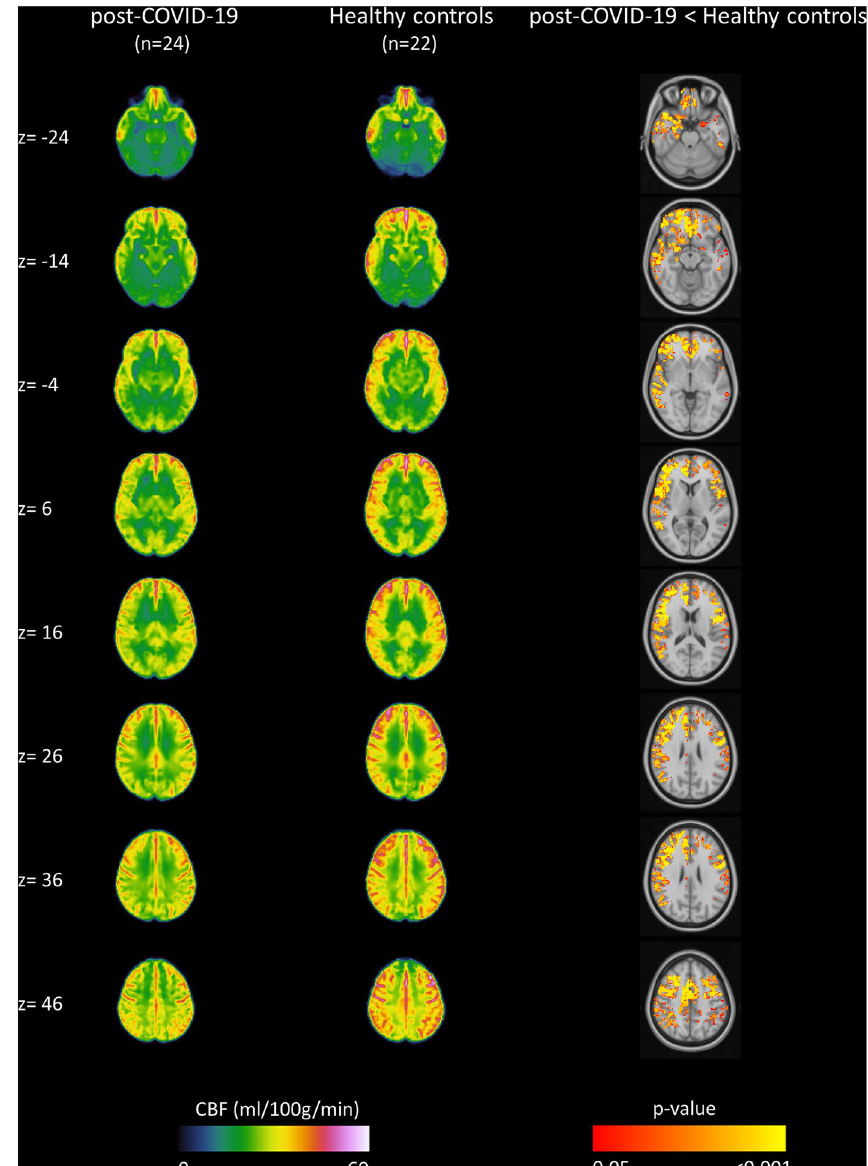
Figure 1. Result of group analysis of MRI-ASL data. The group averaged cerebral blood flow (CBF) maps (ml/100 g/min) calculated for the post-COVID-19 group (left column) and healthy subjects (middle column). Right column depicts regions that show significant hypoperfusion in post-COVID-19 patients compared to healthy controls (non-parametric permutation test, p < 0.05, FWE-corrected with TFCE). No regions with a significantly higher perfusion in post-COVID-19 patients compared to healthy controls were detected. Images are reported in the 2-mm MNI152 standard space and in radiological